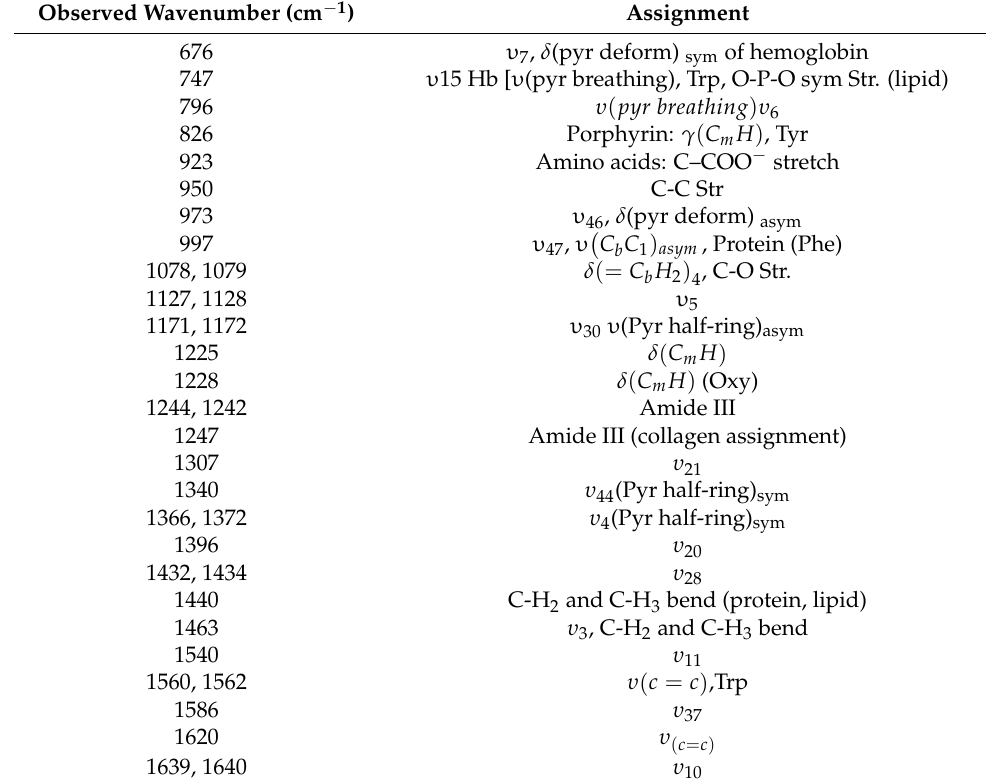
Table 1. Raman peak